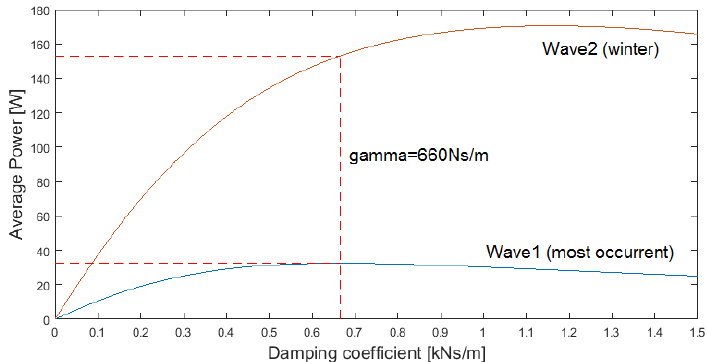
Figure 9. The two curves in the figure show the relation between different damping coefficients and average power for Wave1 and